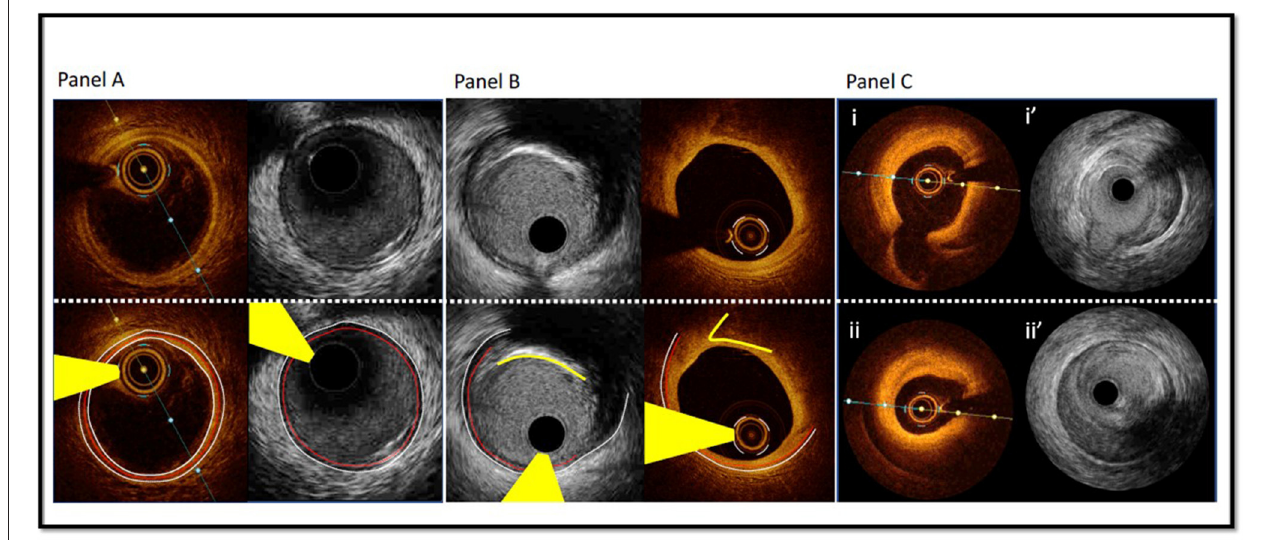
FIGURE 1 | Comparison of Optical Coherence Tomography and Intravascular Ultrasound. Panel A—Matched images of a normal coronary artery using OCT and high-definition IVUS. White dotted line delineates the external elastic membrane, the red dotted line indicates the internal elastic membrane and the white solid line outlines the luminal contour (best identified with OCT). Yellow wedge indicates wire artifact. Panel B—Matched images of fibrocalcific plaque using OCT and high definition IVUS. IVUS facilitates greater visualization of the EEM border due to attenuation of the deep wall structures by OCT (most evident at 3–4 o’clock). OCT’s resolution and characteristic sharp edged delineation of calcific plaque (yellow solid line) allows enhanced assessment of overlying fibrous tissue. Panel C—Matched images of a spontaneous coronary artery dissection using high-definition IVUS and OCT. Images i/I’ demonstrate intima-medial separation from the EEM at the level of a small sidebranch. Images ii/ii’ demonstrate intramural haematoma with some attenuation of deeper structures on OCT and excellent deep wall visualization with